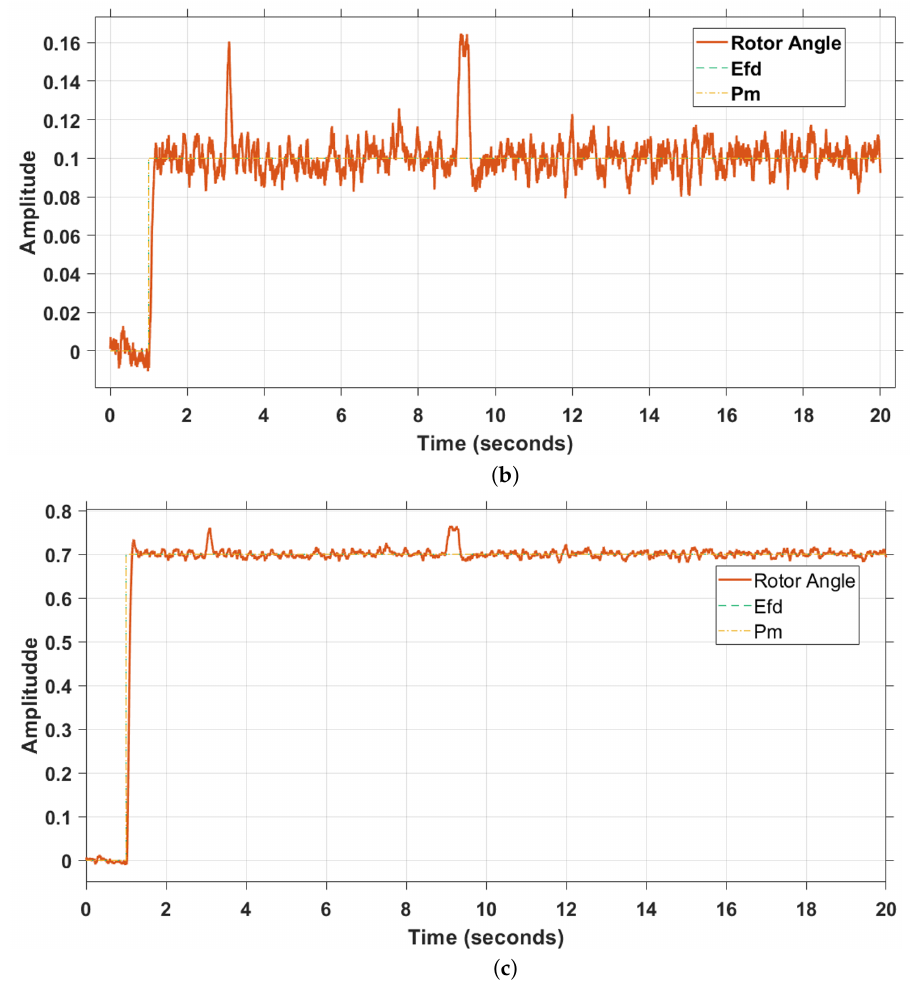
Figure 10. Synchronous generator rotor angle with bounded inputs. ( a ) Inputs varied from 0.1 to 7 without disturbance; ( b ) inputs at 0.1 with Gaussian noise; (c) inputs at 0.7 with